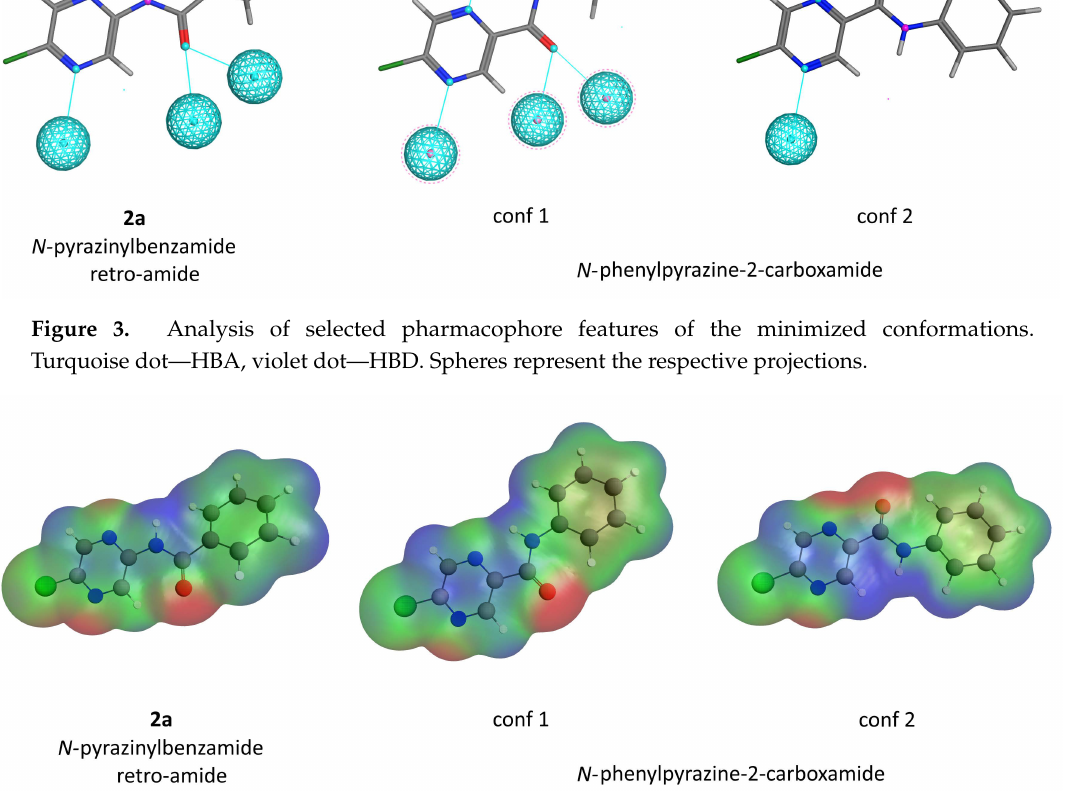
Figure 4. Total electron density isosurface colored by molecular electrostatic potential